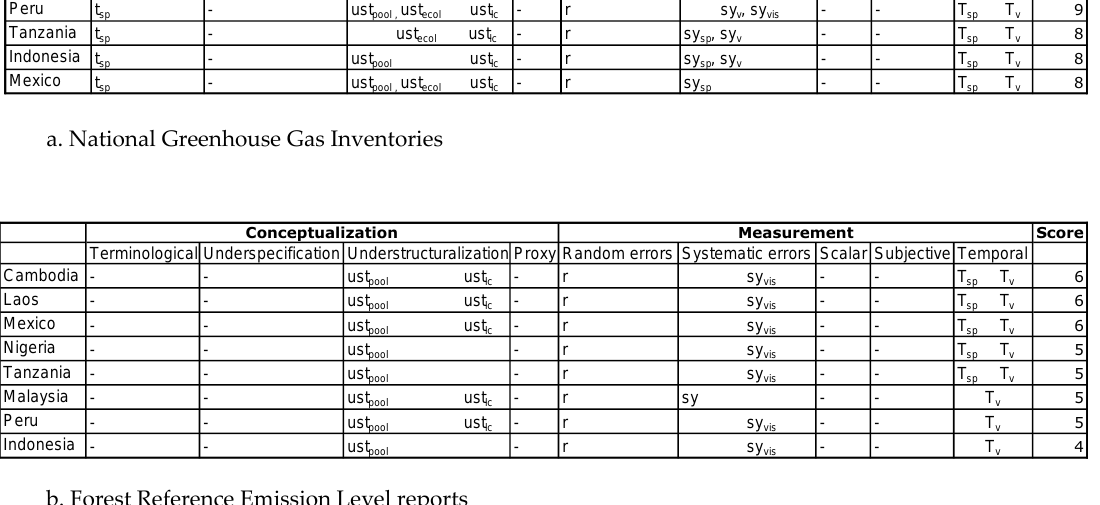
Figure 8. Uncertainty Fingerprints for eight tropical countries of estimates of gross deforestation